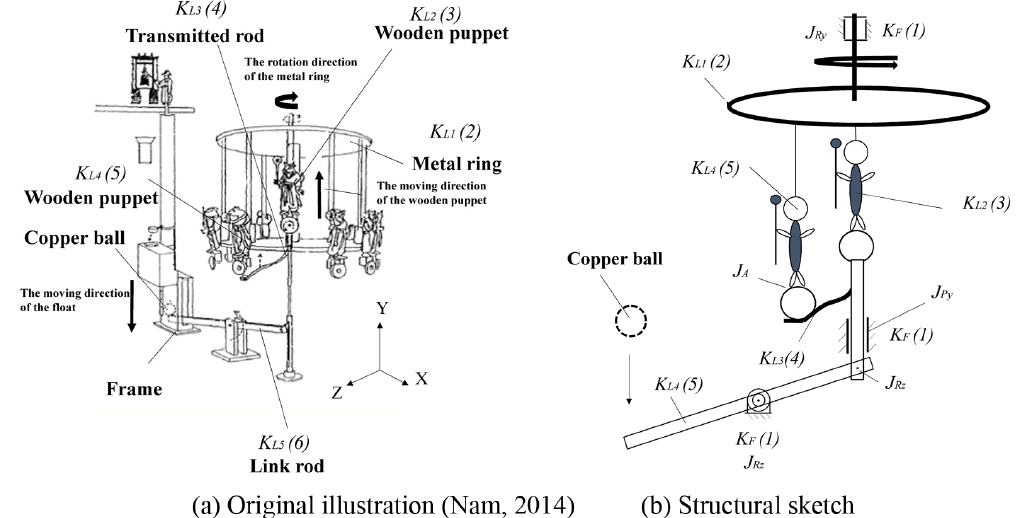
Figure 17. Jiang Ying Shi’s 12h God device.